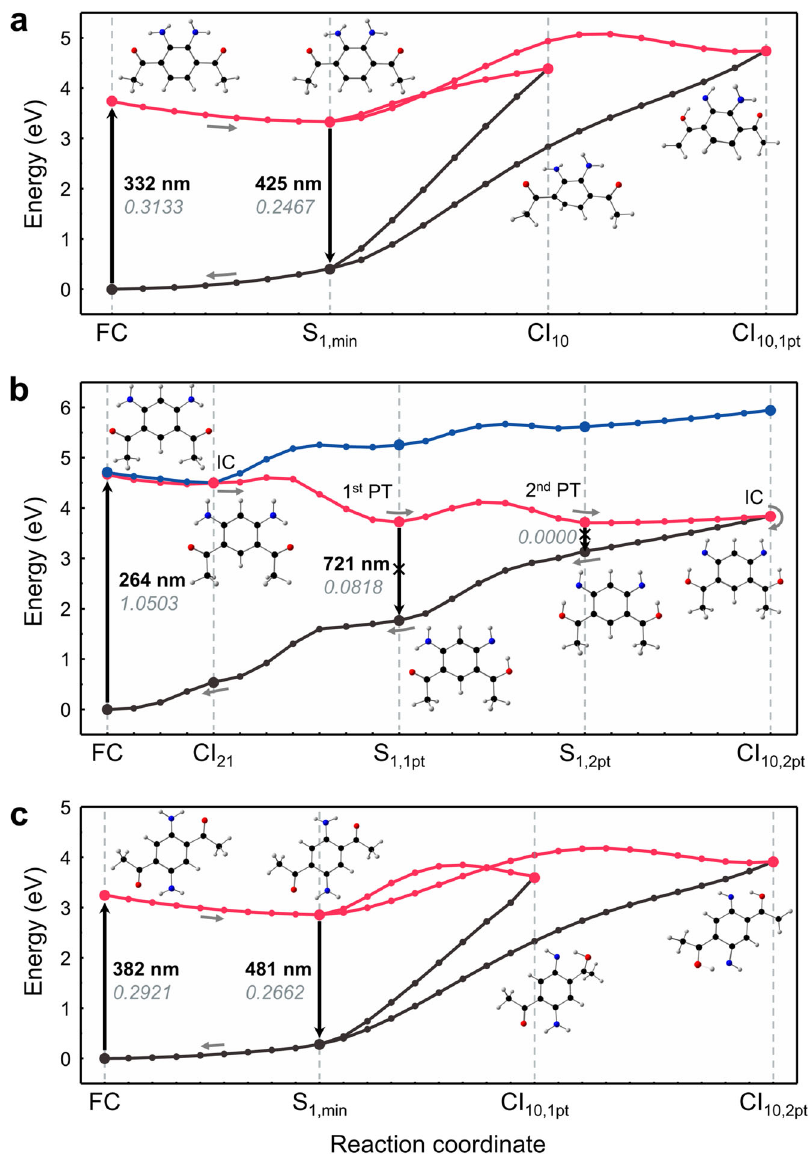
Fig. 5 Potential energy surfaces. Calculated S 0 (black), S 1 (red), and S 2 (blue) potential energy surfaces of o -DAPA ( a ), m -DAPA ( b ), and p -DAPA ( c ). The geometries were optimized at the MRSF/BH&HLYP/6-31 G* level of theory. Using computed structures, minimum energy paths (MEPs) were constructed, and optimized using the geodesic interpolation method 55 . For each transition, calculated wavelengths and oscillator strengths are shown in bold and italic, respectively. FC Franck – Condon region, CI conical intersection, IC internal conversion, PT proton